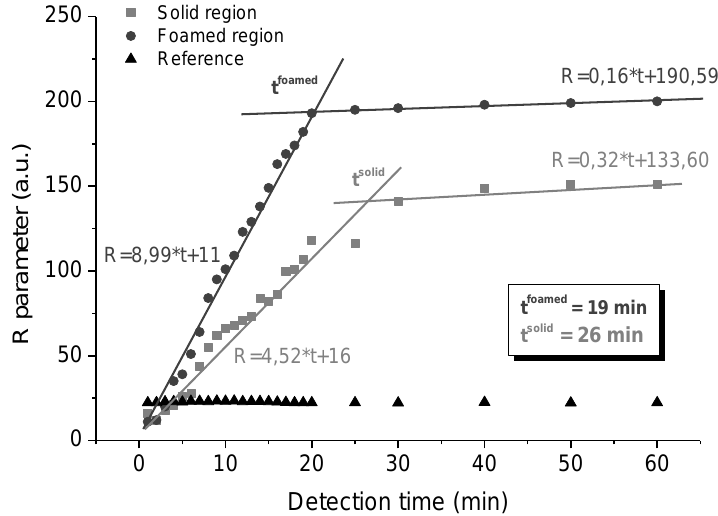
Figure 3. Evolution of the red parameter (R) of images of sensory films, and reference along time immersed in the aqueous solution of Hg(II) (913 ppm, Hg(NO 3 ) 2 , pH 2.2 buffered: